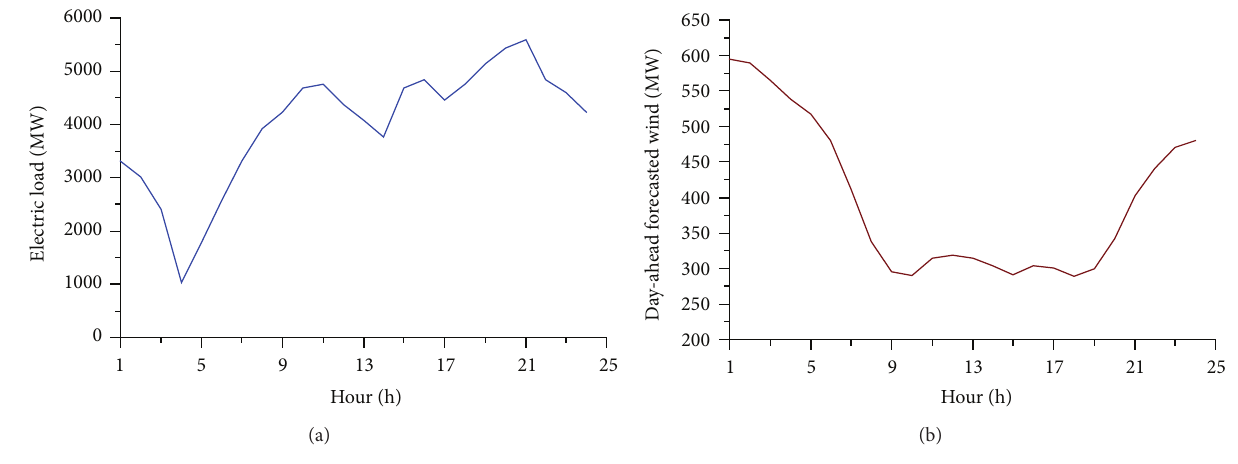
Figure 4: (a) Electric load profile. (b) Day-ahead forecasted wind power output.